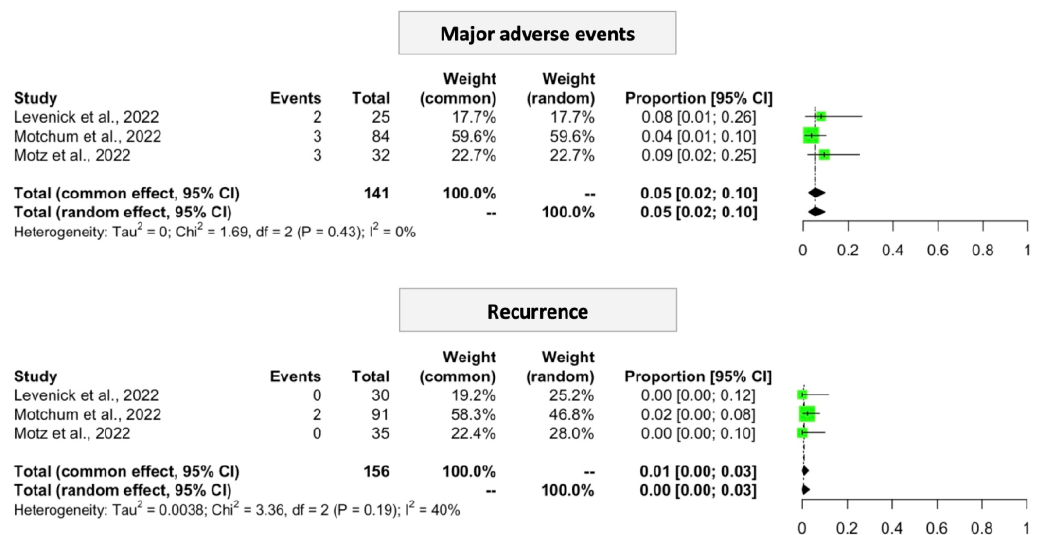
Figure 4. Proportions of major adverse events and of recurrence at 6 months after hybrid argon plasma coagulation (hAPC)-assisted endoscopic mucosal resection (EMR) of colonic lesions with more than 20 mm. Events = number of patients presenting major adverse events or recurrence; total = number of patients evaluated in which study. References of the studies: Levenick et al., 2022 [12]; Motchum et al., 2022 [10]; Motz et al., 2022 [11].